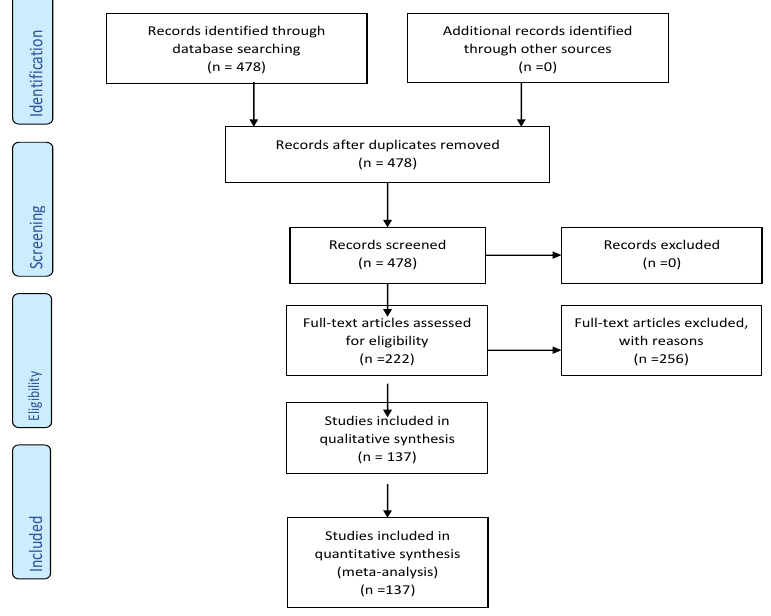
Figure 1. Study selection summary.